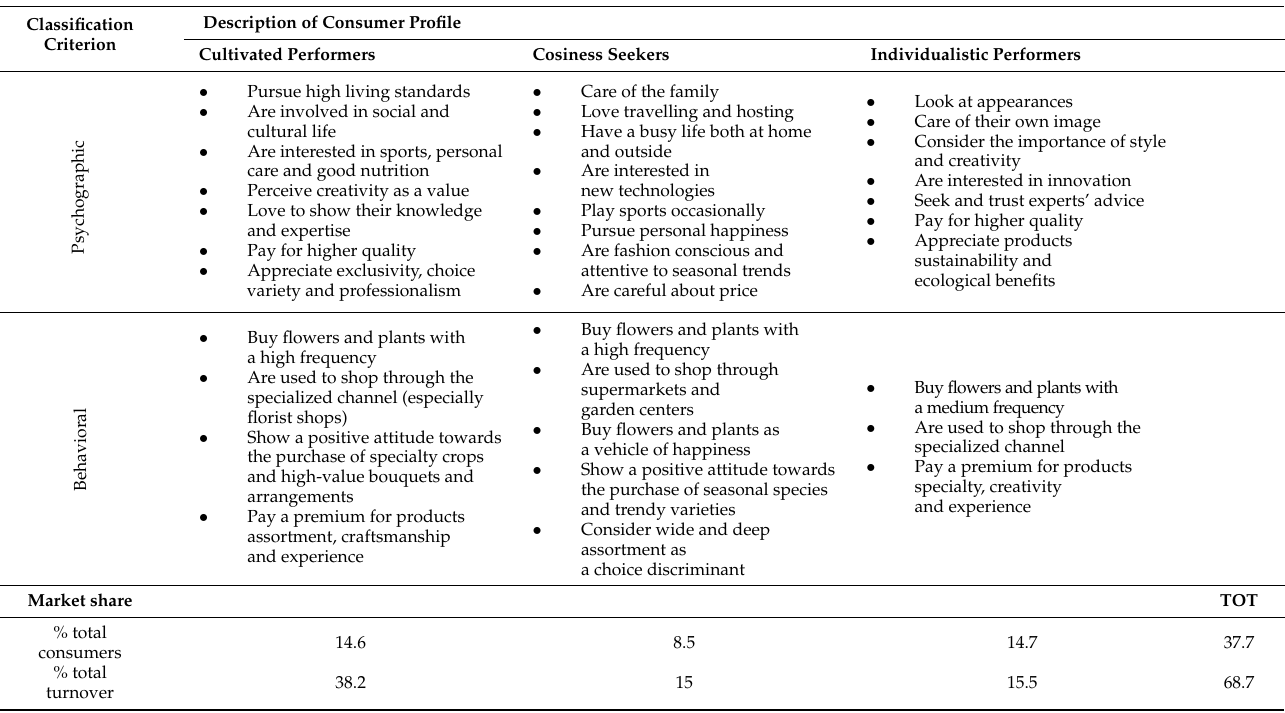
Table 6. High-value consumer profiles in the European market for cut flowers and indoor plants: a multivariable